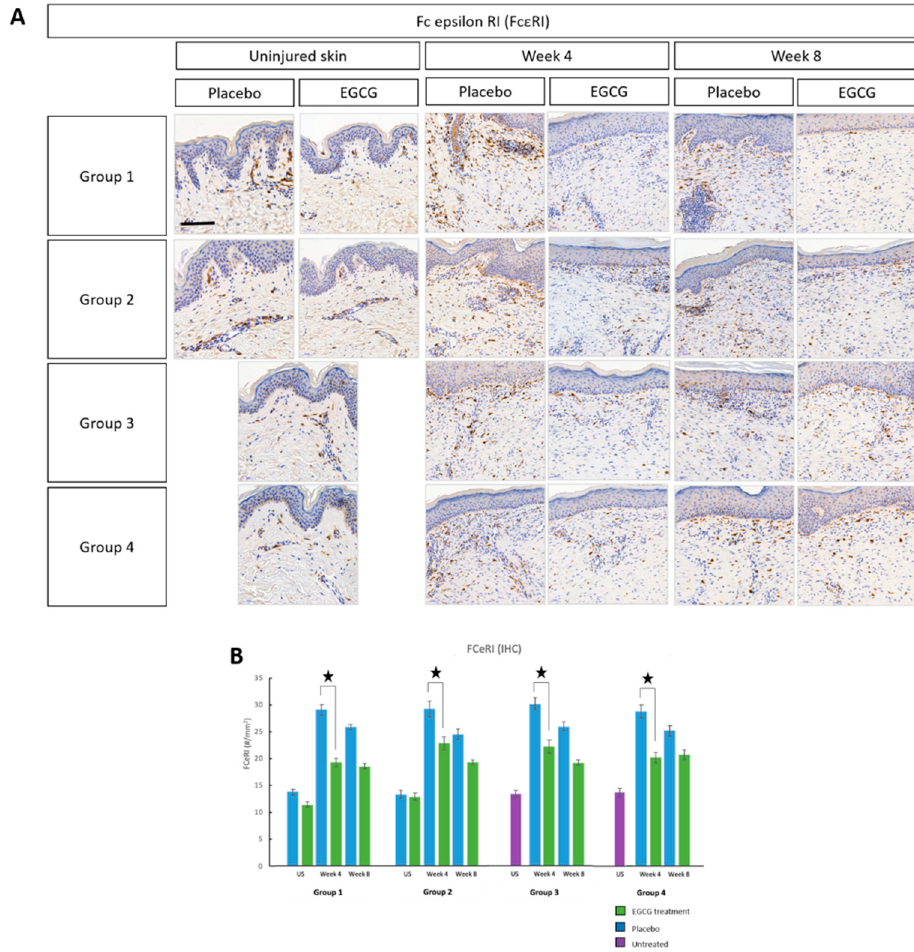
Figure 7. Immune cell marker analysis of topical epigallocatechin-3-gallate (EGCG) versus placebo (Fc epsilon RI (Fc ε RI)). ( A ) Fc ε RI immunohistochemical images demonstrated a reduction in expression in EGCG samples compared to placebo. Scale bars = 50 µ m. ( B ) There were greater levels of Fc ε RI in scar tissue compared to uninjured skin predominantly at scar edges and less centrally, and this was highest at week 4 in all groups. There was a significant reduction in Fc ε RI at week 4 in EGCG treated samples compared to placebo in all groups ( p < 0.01) but no significant difference between groups. Significance: ★ p <0.05 Scale bars = 50 μ m.